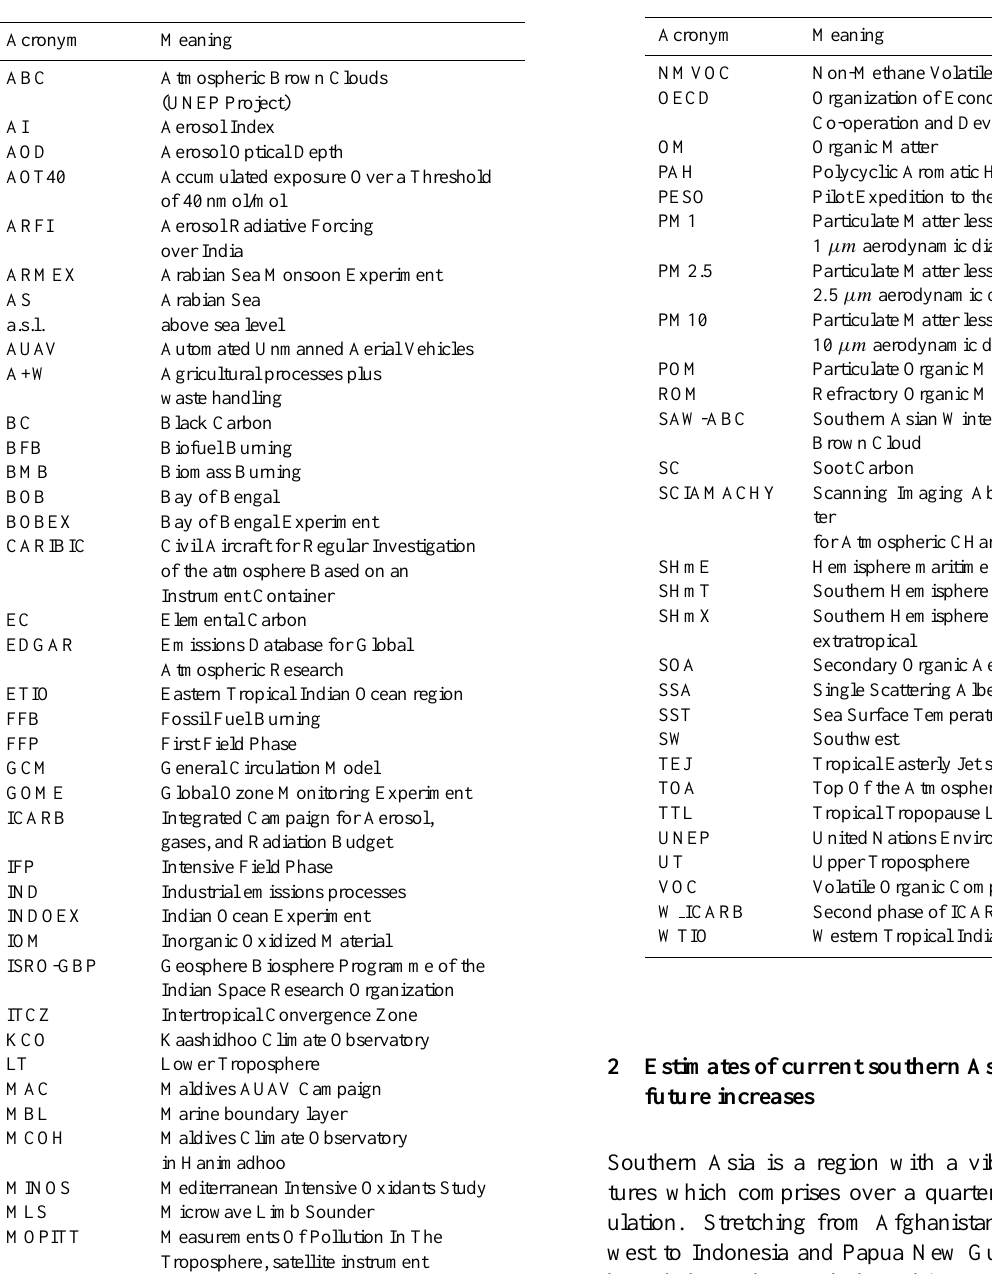
Table 1. Listing of acronyms used in the